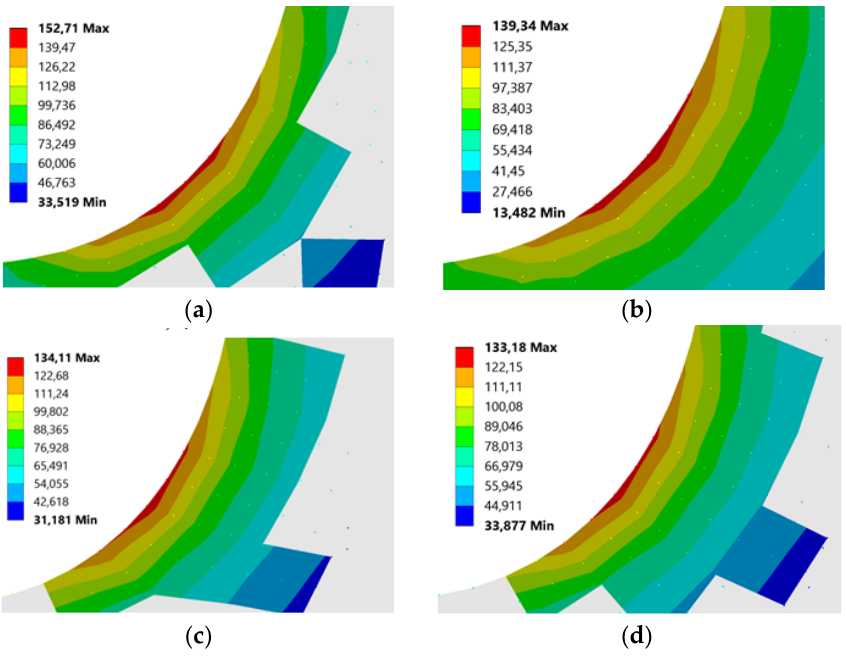
Figure 9. Root stress results for hybrid gears generated rack tip radius, ρ 1 = 0.3 xm for different RTs; ( a ) 0.5 xm, ( b ) 1 xm, ( c ) 1.5 xm, ( d ) 2 xm.